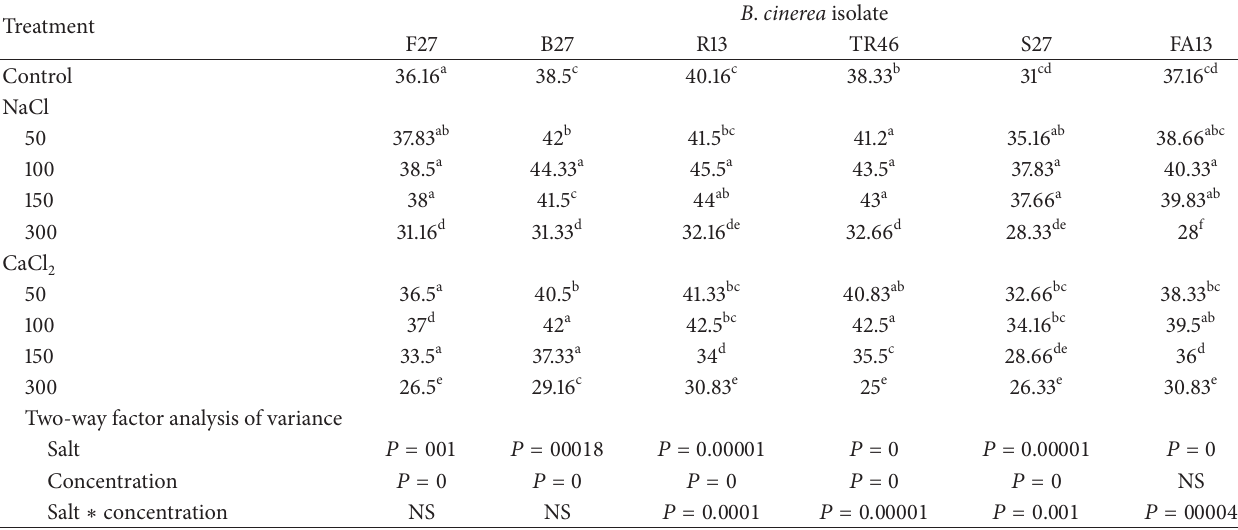
Table 1: Effect of different concentrations of NaCl and CaCl cinerea in PDA medium after incubation at 25 ∘ C for 3 days.